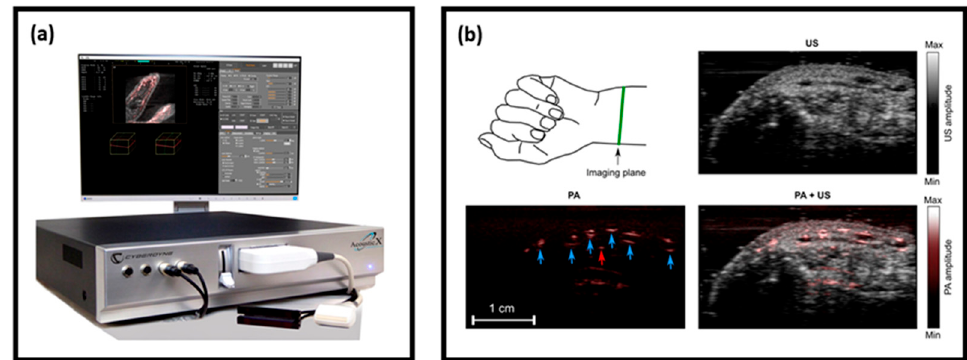
Figure 9. ( a ) Photograph of the LED-based PA and US imaging system—AcousticX; ( b ) US (gray colormap), PA (hot colormap), and US/PA overlay cross-section images of a human volunteer’s wrist acquired at a frame rate of 10 Hz. Blood vessels are marked using blue arrows in the PA image. Adapted with permission from W. Xia, M. Kuniyil Ajith Singh, E. Maneas, N. Sato, and A. E. Desjardins, Sensors,